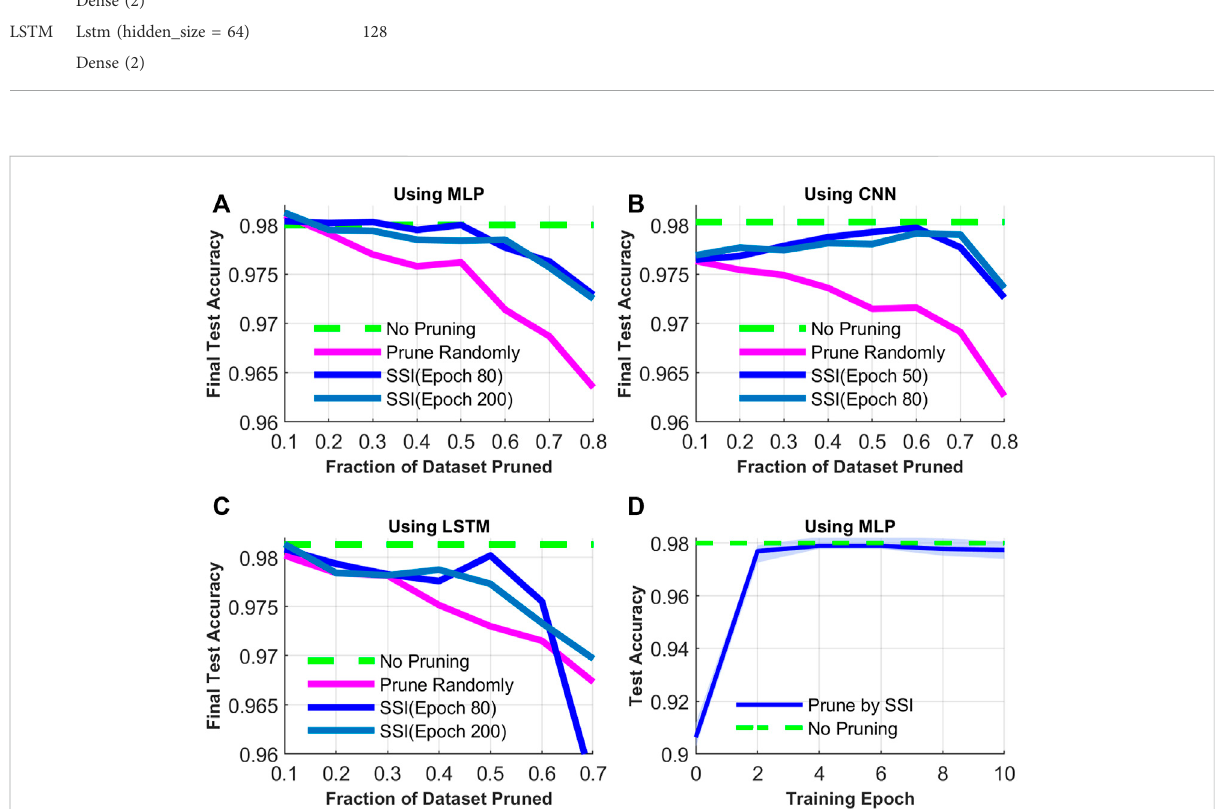
FIGURE 5 The in fl uence of the pruning fraction and SSI of different training periods on the fi nal accuracy. (A) to (C) show the test accuracy with different fractionsof datasets pruned and pruning strategies using MLP, CNN, and LSTM. (D) shows the test accuracy of MLP using different SSI from different training